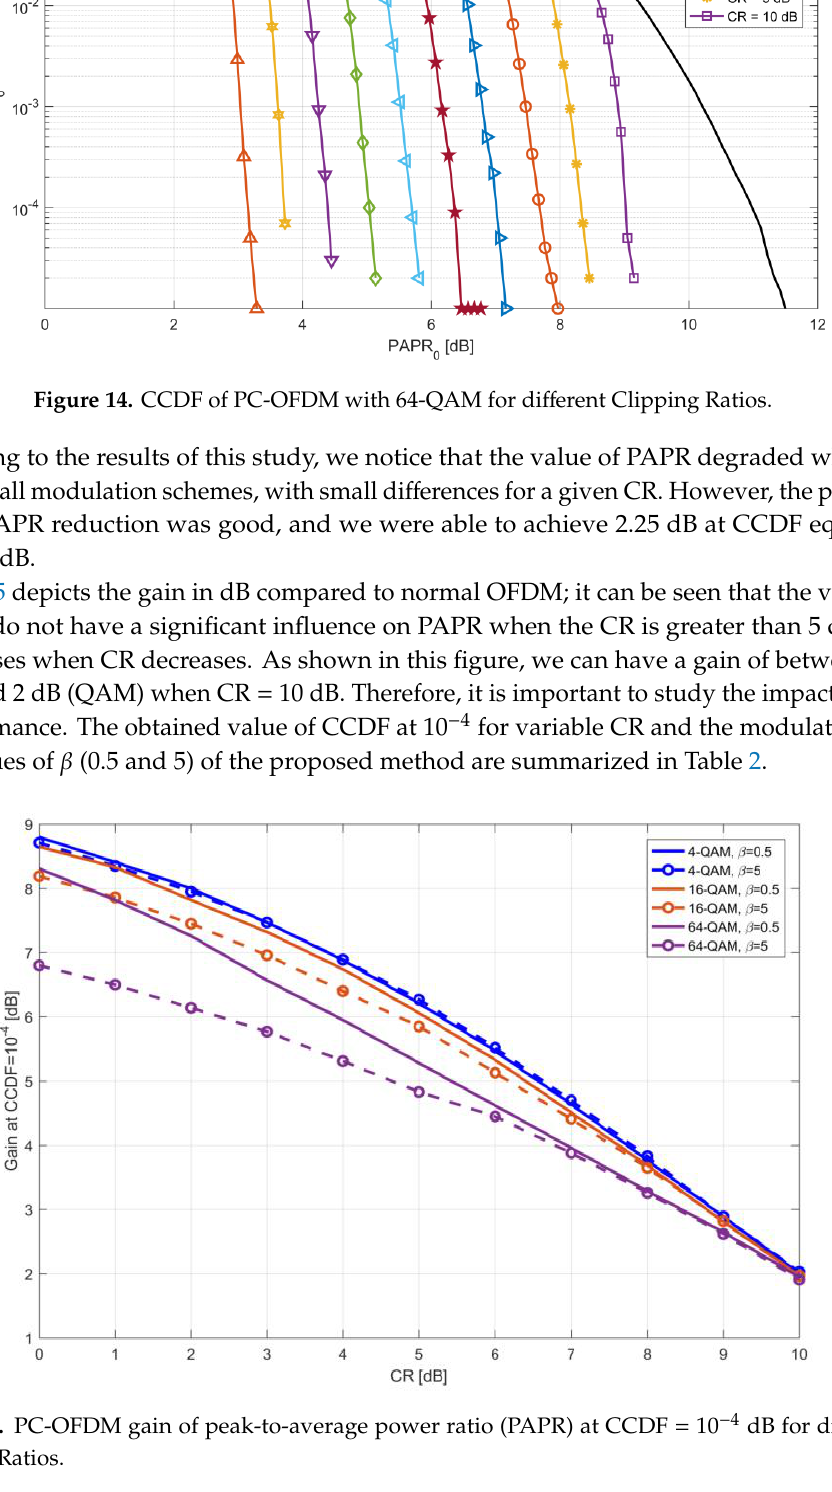
Figure 13. CCDF of PC-OFDM with 16-QAM for different Clipping Ratios.